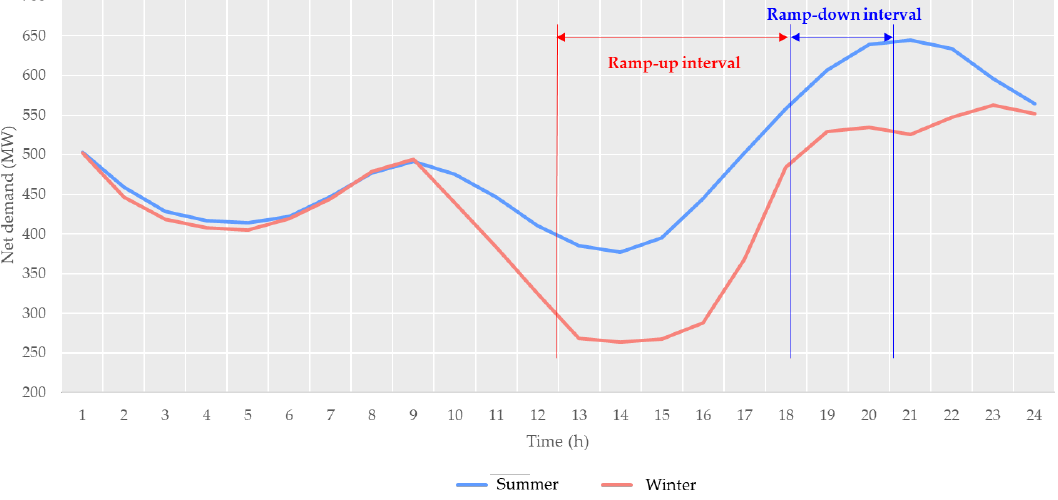
Figure 1. Ramp-up/down intervals based on the net-demand profile of summer and winter [15].